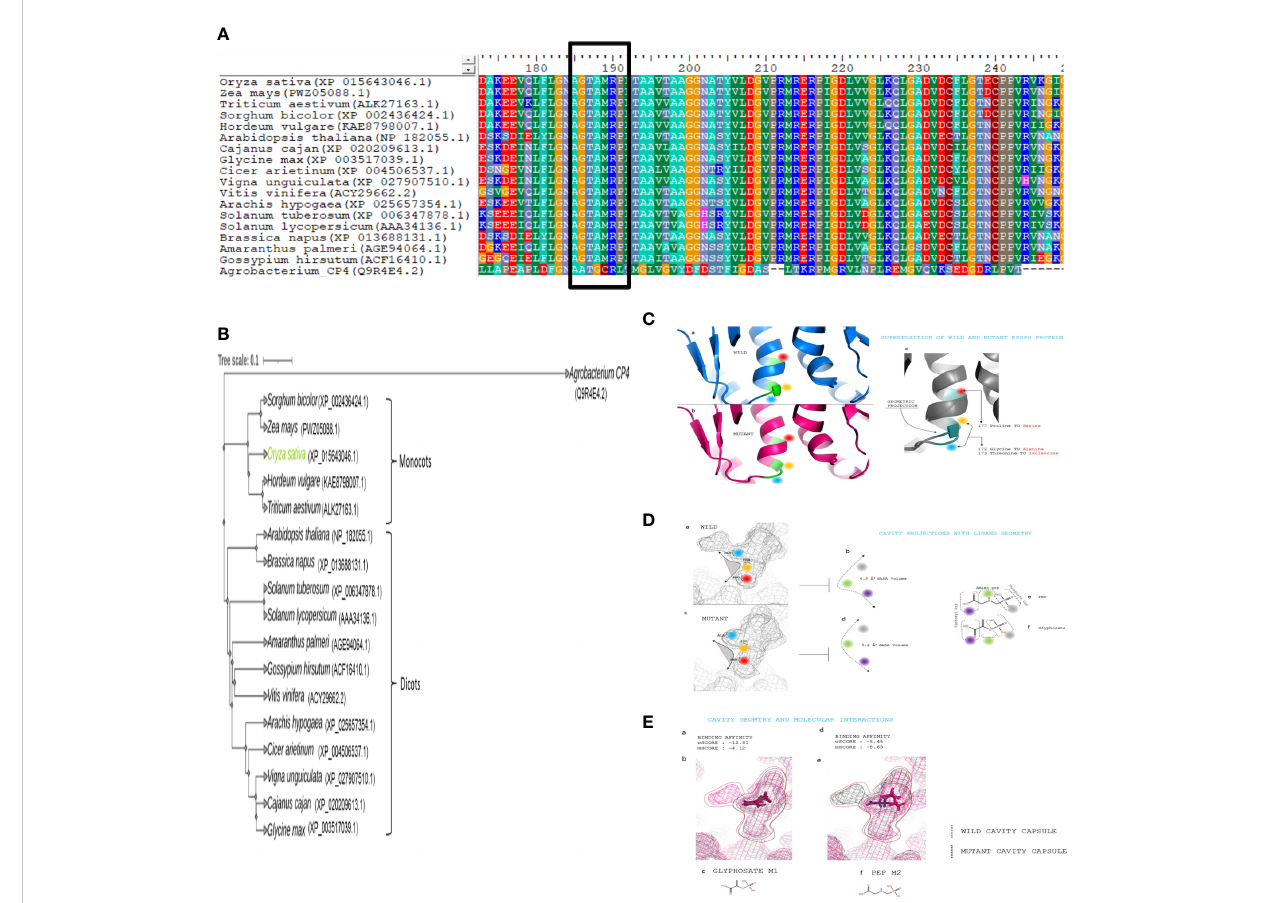
FIGURE 1 In silico analysis and identi fi cation of glyphosate-resistant (GR) mutations site (A) The conserved amino acid (G172, T173, and P177) sites in EPSPS protein of different plants (B) Phylogenetic analysis of EPSPS protein of different plants. (C) (a) Wild structure of EPSPS protein in ribbon-like representation with positioning of selected amino acid to edit. (b) Mutant structure of EPSPS protein in ribbon-like representation with positioning of selected amino acid to edit. (c) Superpositioned structure of mutant and WT EPSPS proteins for geometrical projections. Position of 172, 173, and 177 amino acids are highlighted as blue, yellow, and red, respectively. (D) (a) Active site volume of wild EPSPS protein, highlighting the selected three amino acids to edit. (b) The area of the volume within the selected amino acids. (c) Active site volume of Mutant EPSPS protein, highlighting the selected three amino acids to edit. (d) The area of the volume within the selected amino acids. (e) Two-dimensional structure of PEP, mentioning the position of phosphate, amino, and carboxyl group. (f) Two-dimensional structure of glyphosate, mentioning the position of phosphate, amino, and carboxyl group. (E) (a) Active site volume of wild EPSPS protein, highlighting the selected three amino acids to edit. (b) The area of the volume within the selected amino acids. (c) Active site volume of mutant EPSPS protein, highlighting the selected three amino acids to edit. (d) The area of the volume within the selected amino acids. (e) Two-dimensional structure of PEP, mentioning the position of the phosphate, amino, and carboxyl group. (f) Two-dimensional structure of Glyphosate, mentioning the position of phosphate, amino, and carboxyl